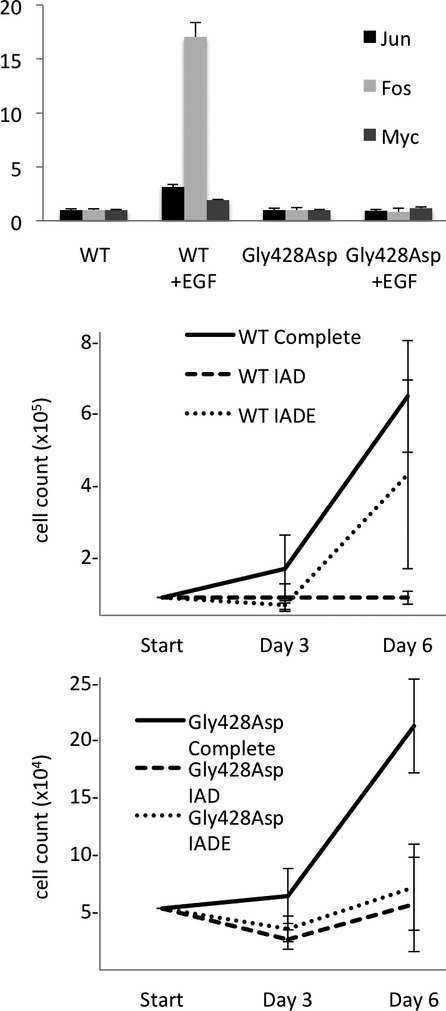
Downstream targets of EGF, Jun (dark bars), Myc (grey bars), and Fos (light bars), are increased in response to stimulation with EGF in control cells, but not patient cells (A). Growth of control cells in a minimal media of insulin, dexamethasone, and ascorbic acid (IAD) (lightest line) can be rescued with EGF treatment (IADE) (middle line) (B), whereas patient cell growth cannot be rescued with EGF (middle line) (C).